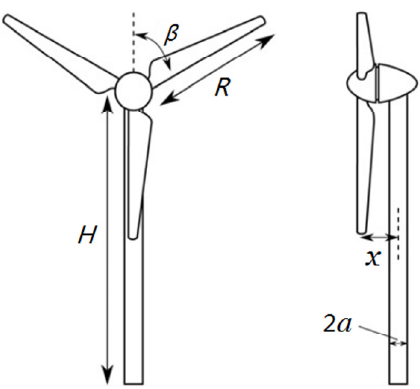
Figure 2. Definition of some dimensional parameters of the wind